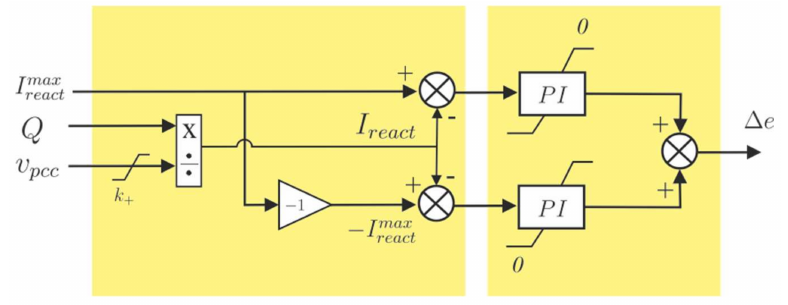
Figure 4. Reactive current limiting (RCL)